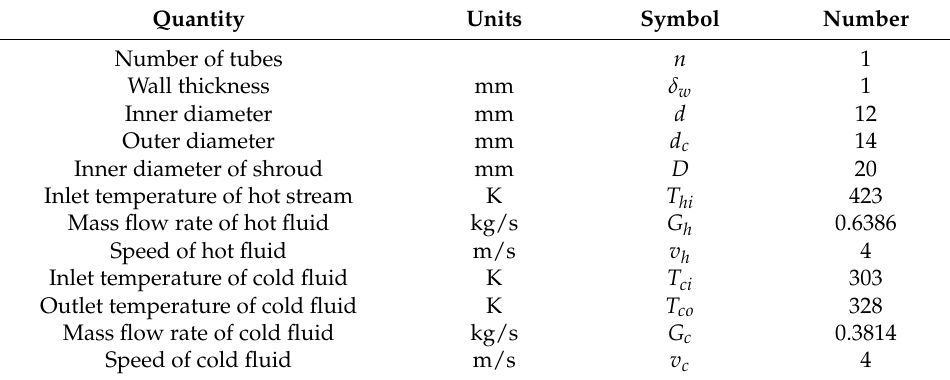
Table 1. Input parameters for thermal